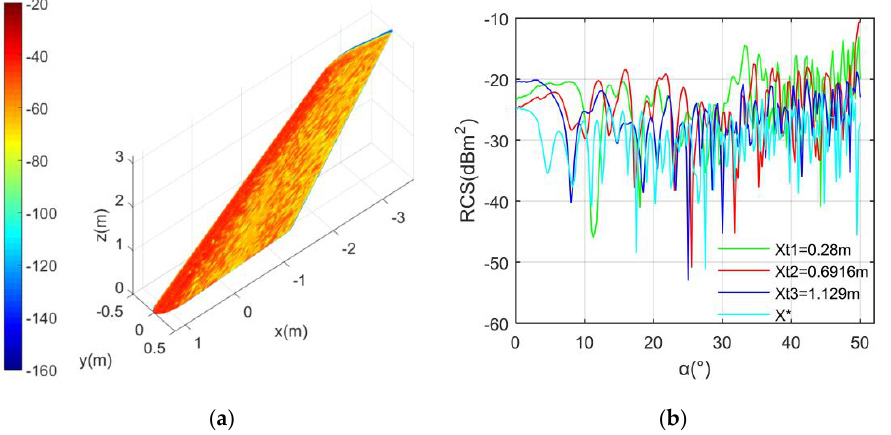
Figure 12. RCS analysis of the vertical tail: RCS unit: dBm 2 ; F rh = 6 GHz; β = 0 °; ( a ) Surface scattering, M ( X *), α = 16 °; ( b ) RCS curve.